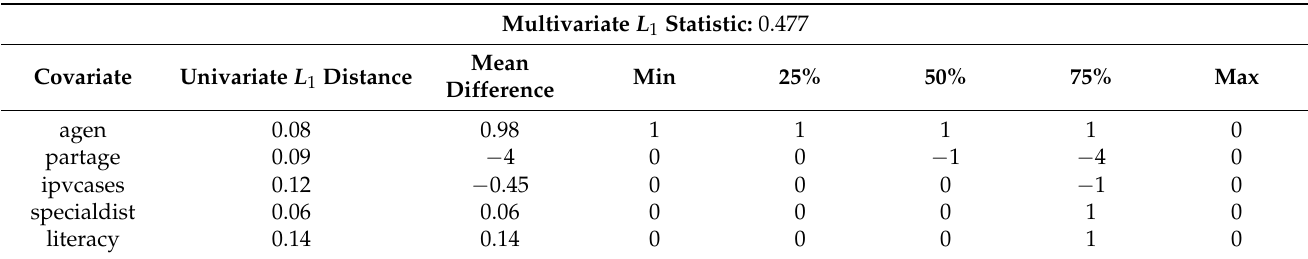
Table 3. Initial imbalance in covariates between treatment and control groups. Multivariate L 1 Statistic: